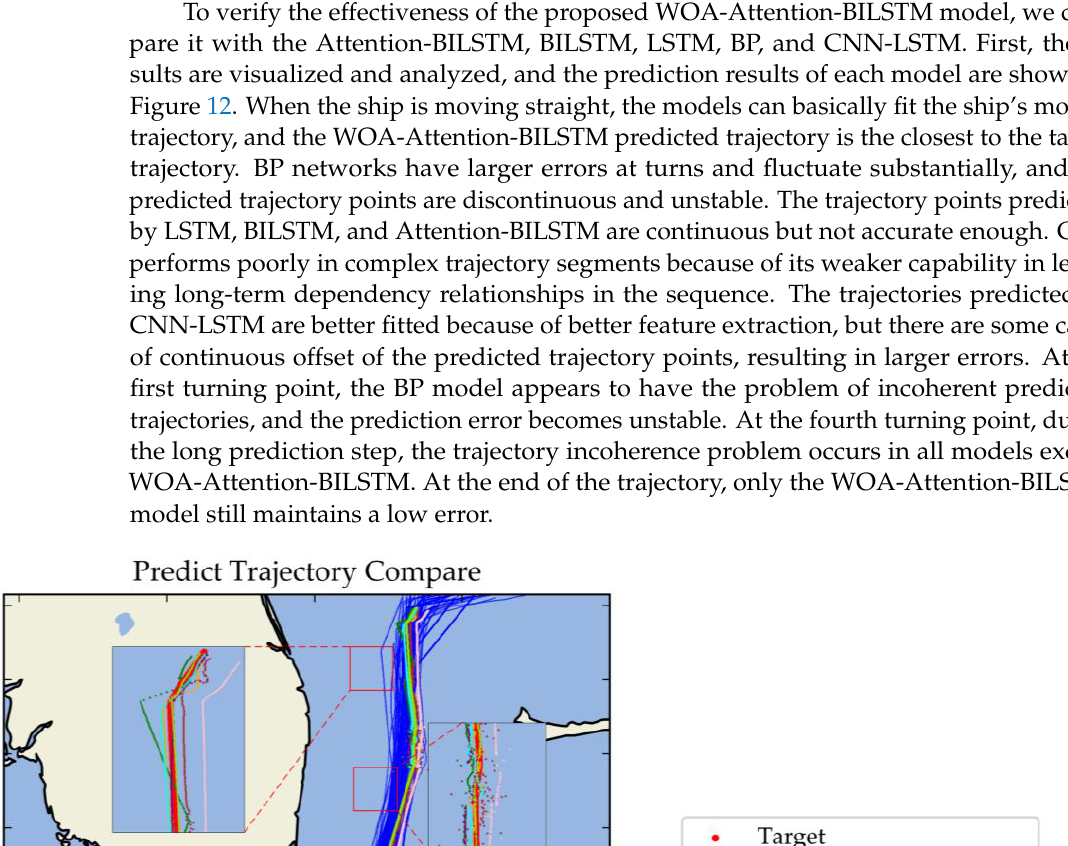
Figure 11. Trajectory of the target ship. The blue lines are the trajectories of other ships in the dataset, and the red line is the target ship’s trajectory.